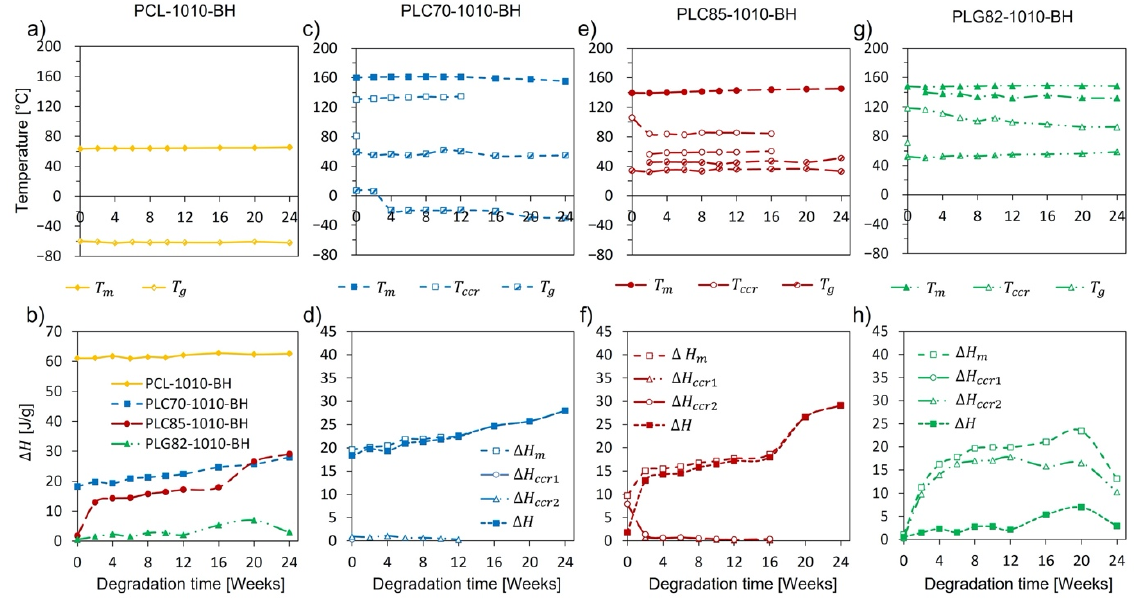
Figure 3. The characteristic temperatures ( a , c , e , g ) and enthalpies ( b , d , f , h ) determined from first heating of DSC for: ( a ) and ( b ) PCL-1010-BH, ( c ) and ( d ) PLC70-1010-BH, ( e ) and ( f ) PLC85-1010- of DSC for: ( a , b ) PCL-1010-BH, ( c , d ) PLC70-1010-BH, ( e , f ) PLC85-1010-BH, ( g , h ) BH, ( g ) and ( h ) PLG82-1010-BH.